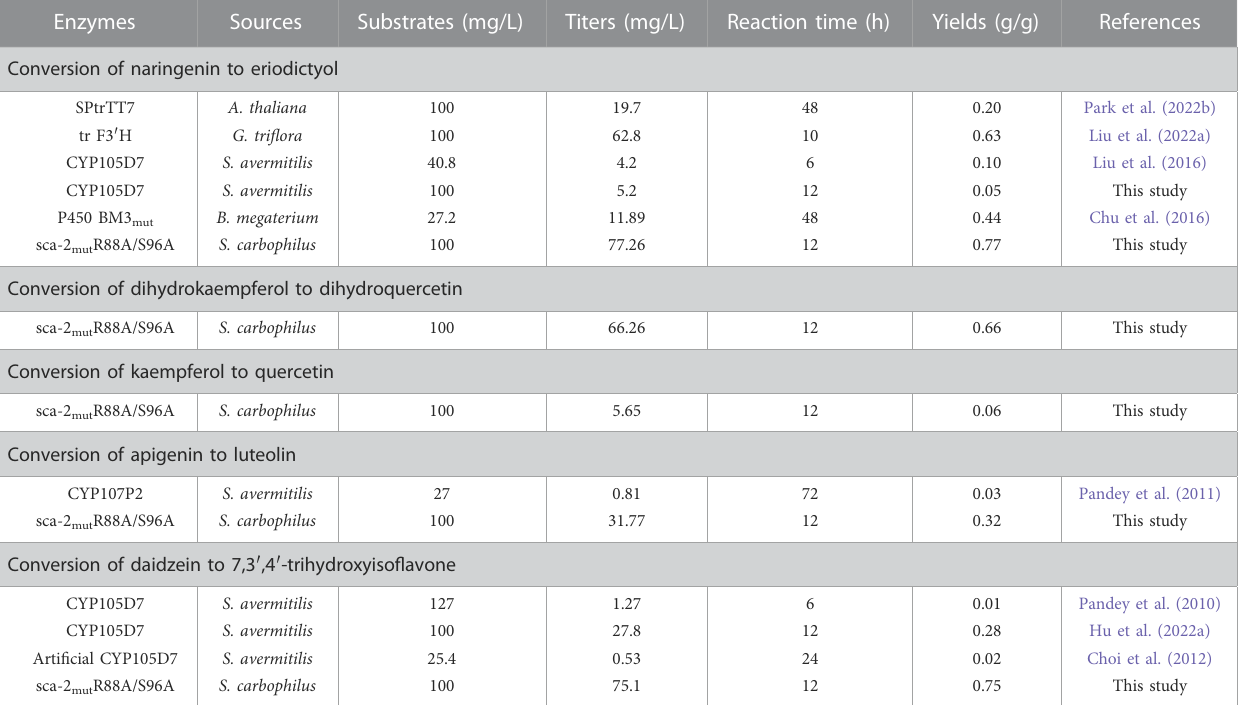
TABLE 1 The overview of known recombinant Escherichia coli whole-cell P450 biocatalysts used for the production of fl avonoids. Enzymes Sources Substrates